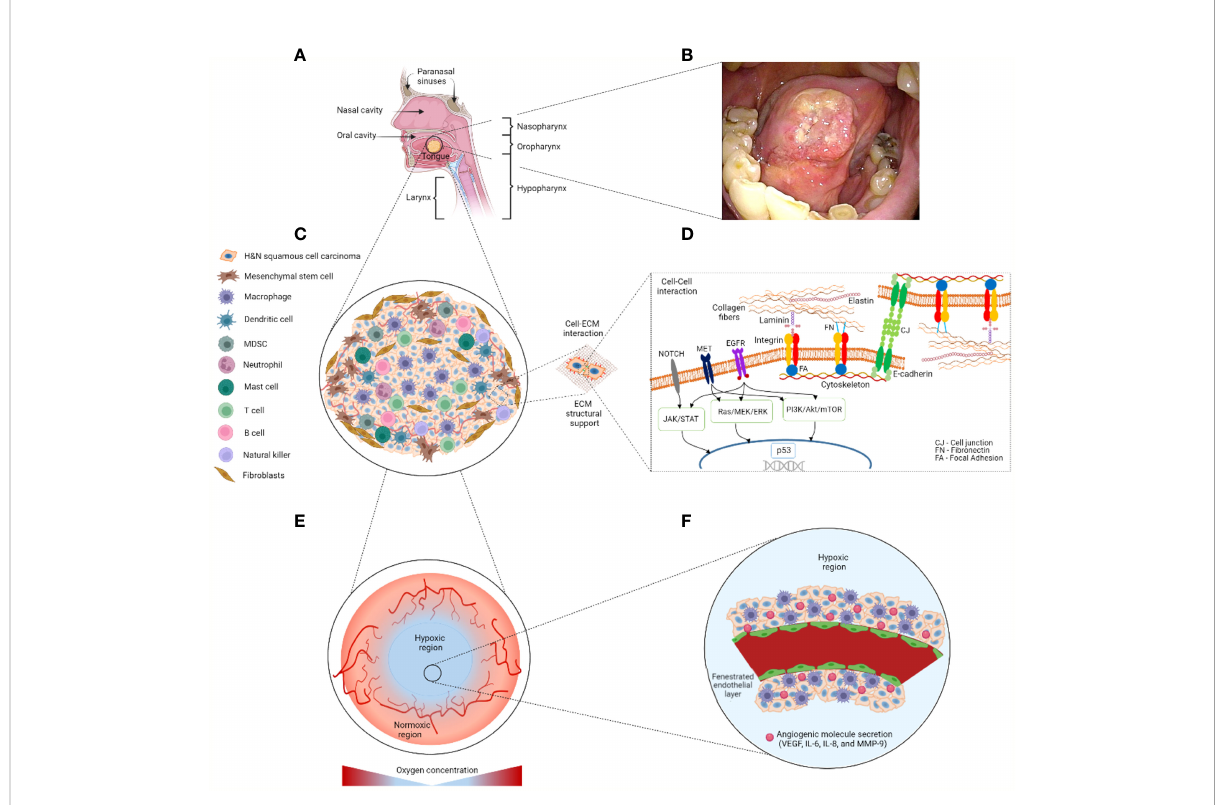
FIGURE 2 Schematic representation of the potential tumor location and tumor microenvironment (TME) in H&N cancer. (A) H&N cancer may be found at oral, nasal, and paranasal cavities, larynx, and pharynx anatomical sites. (B) Clinical image of stage 2 tongue cancer (<4 cm) provided by Drs. Yo Kishimoto and Hideaki Okuyama ’ s research team at the Kyoto University Hospital with patient ’ s consent. (C) Heterogeneous cell populations are resided within an H&N squamous cell carcinoma. Stromal cells including mesenchymal stem cells and fi broblasts are commonly found in the outer layer of the tumorous body. Tumor-in fi ltrating immune cells including macrophages and T cells among others are found within the tumor. (D) The extracellular matrix provides structural support and biochemical cues to the TME via cell – cell/ – ECM interactions. Mutation of pathways PI3K/Akt/mTOR, TP53, NOTCH, EGFR, JAK/STAT, Ras/MEK/ERK, and MET relate to H&N cancer development. (E) The hypoxic region is located at the center of the tumor, which is characterized by aberrant vasculature. (F) This fenestrated vasculature hampers the proper supply of nutrients, oxygen, and therapeutics. ECM, extracellular matrix; IL, interleukin; MDSC, myeloid-derived suppressor cell; MMP, metalloproteinase; VEGF, vascular epithelial growth factor. Figure created with